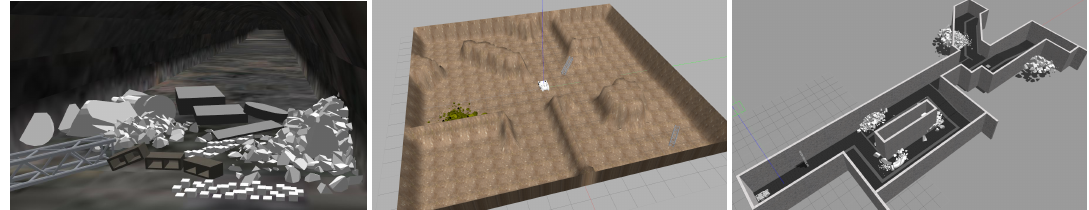
Figure 6. Scenarios for evaluation. Left: tunnel environment with obstacles for navigation (navigation map). Center and right: environments for evaluation of the exploration and navigation (exploration maps 1 and 2